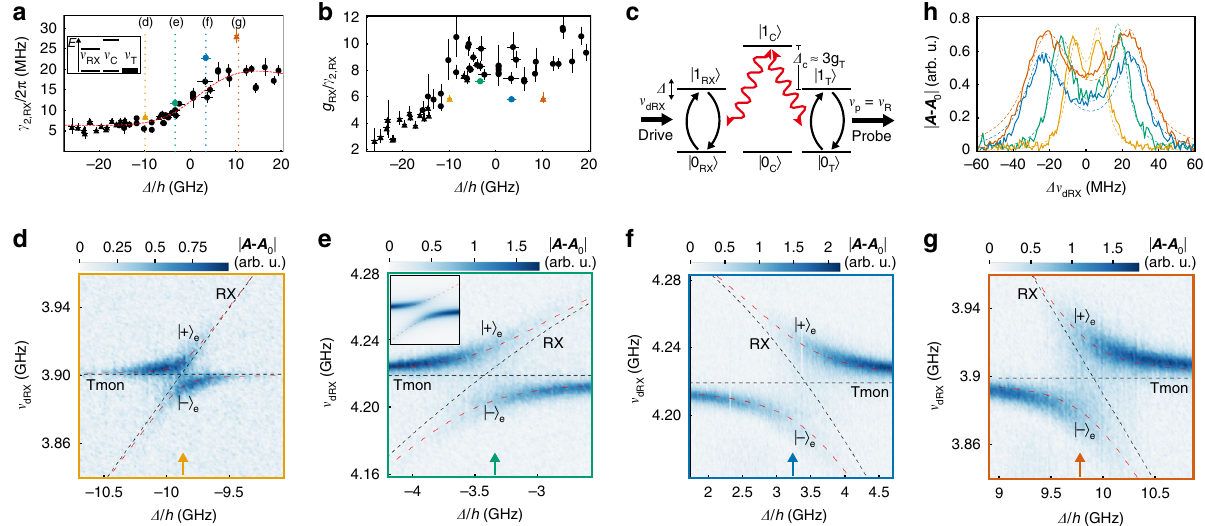
as a function of detuning Δ . The dotted vertical Fig. 3 RX qubit working points and virtual-photon-mediated interaction. a RX qubit decoherence rate γ 2 ; RX lines specify the four working points used in d – g . The corresponding colored data points were obtained for a coupling resonator-RX qubit detuning of ν (cid:3) ν ’ ð 13 : 7 ; 8 : 0 ; 5 : 1 ; 4 : 4 Þ g for Δ = h ’ ð(cid:3) 9 : 9 ; (cid:3) 3 : 3 ; 3 : 4 ; 10 : 2 Þ GHz and the RX qubit tunnel coupling con fi gurations 3 (circle) and 4 (triangle). For C RX RX (cid:3) ν (cid:9) 9 : 7 g the black data points, ν with qubit tunnel coupling con fi guration 1 (circle) and 2 (triangle). The dashed red line is a fi t of a model (see C RX RX main text) to the black data points. Error bars indicate the standard error of fi ts and an estimated uncertainty of the RX qubit energy of 50 MHz . b Ratio of g , as obtained from theory, and γ as shown in a . The color and shape code of the data points is the same as in a . c Schematic of the measurement RX 2 ; RX scheme. Bare qubit transitions (black arrows) are coupled by virtual photon excitations (red arrows) in the detuned coupling resonator ( 0 = 1 j i are the two C lowest photon number states). The RX qubit is driven at frequency ν , the transmon is probed via the read-out resonator at frequency ν . d – g Two-tone dRX R ¼ ν ’ 5 : 6 GHz as a function of Δ and drive frequency ν spectroscopy at ν . Dashed black (red) lines indicate transmon (Tmon) and RX qubit energies p R dRX in the absence (presence) of coupling. The frame color refers to the RX qubit working points as speci fi ed in a . The inset in e shows the result from a master equation simulation with the same axes as the main graph. h Two-tone spectroscopy response from panels d – g at Δ as speci fi ed with arrows in the (cid:8) ν (cid:3) Δ ν corresponding panels. The cuts are centered around zero by accounting for a frequency offset ν . The dashed lines show dRX ; 0 dRX dRX